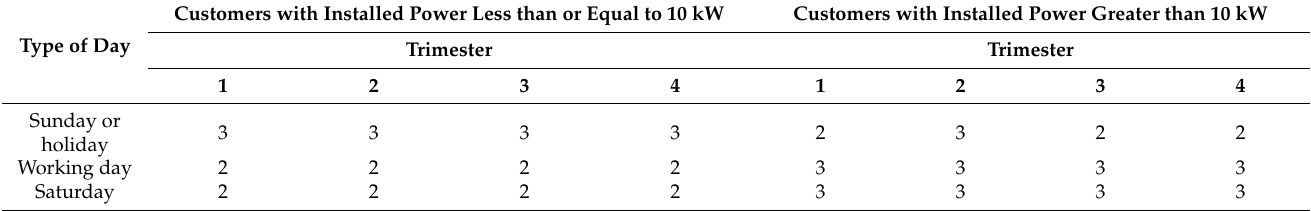
Table 3. Optimal number of groups (k) for typical days per quarter, in industrial customers.